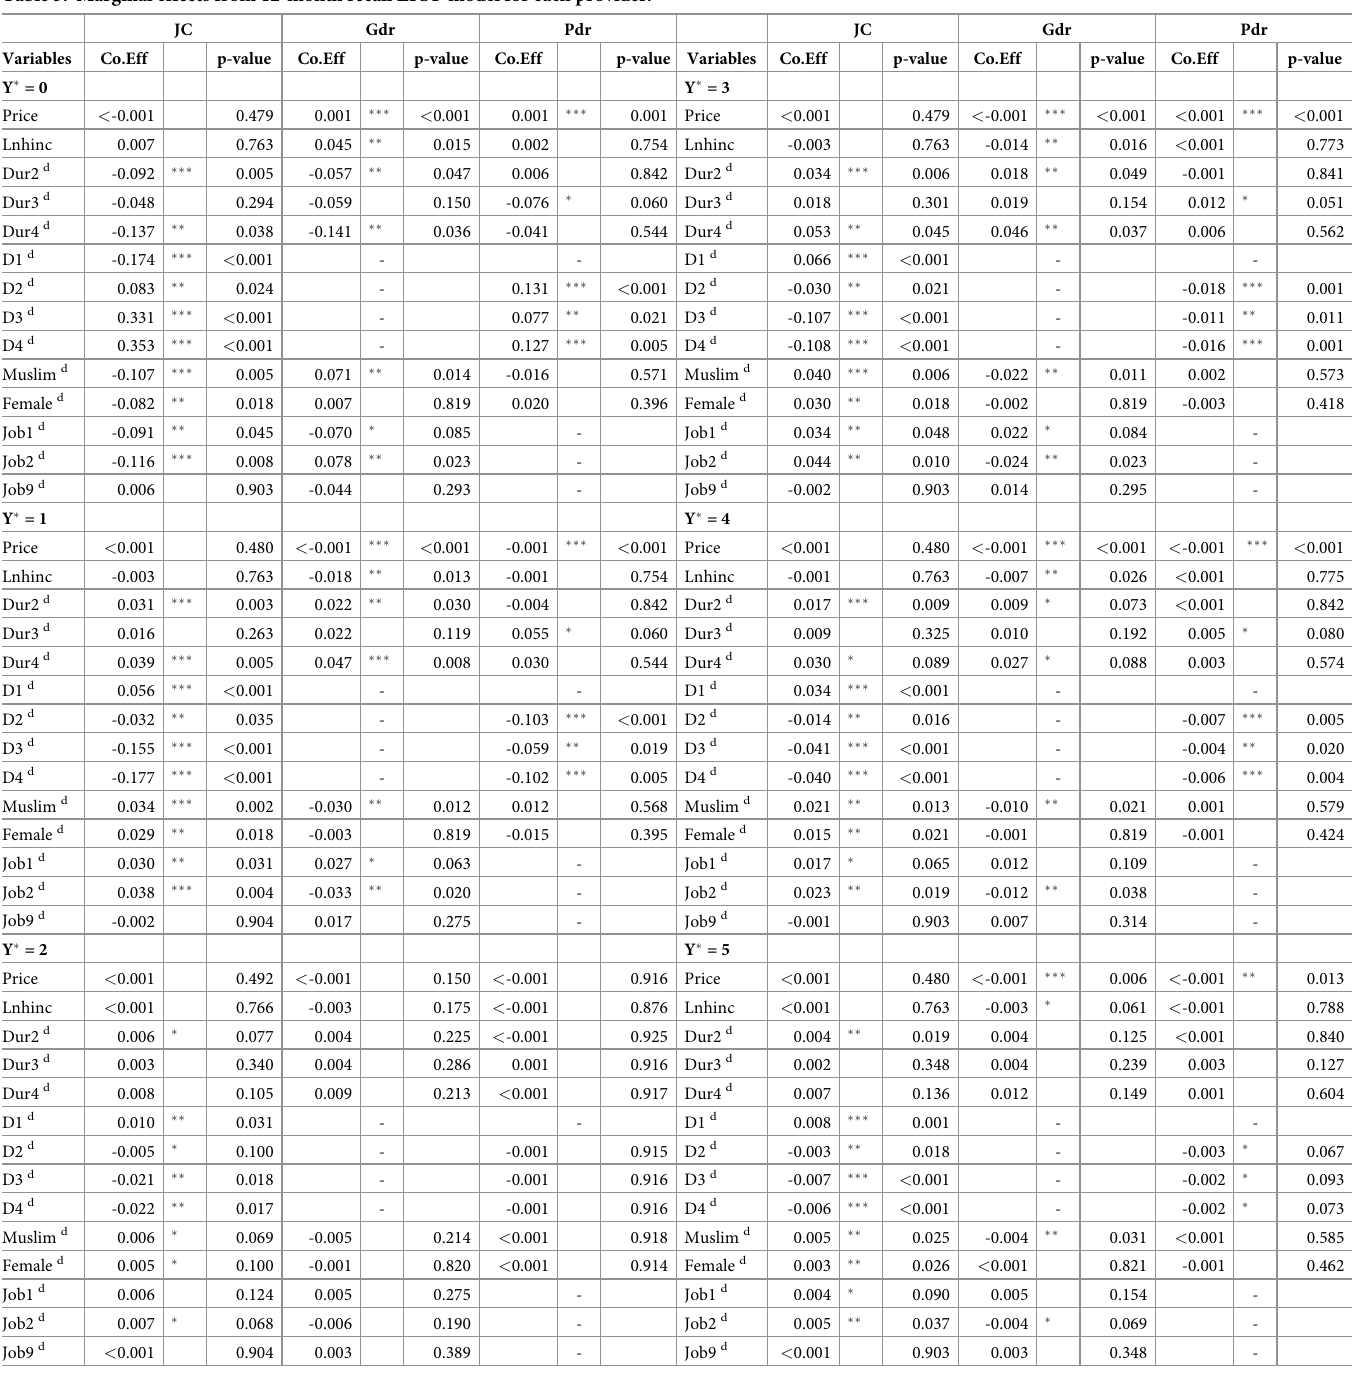
Table 3. Marginal effects from 12-month recall ZIOP model for each